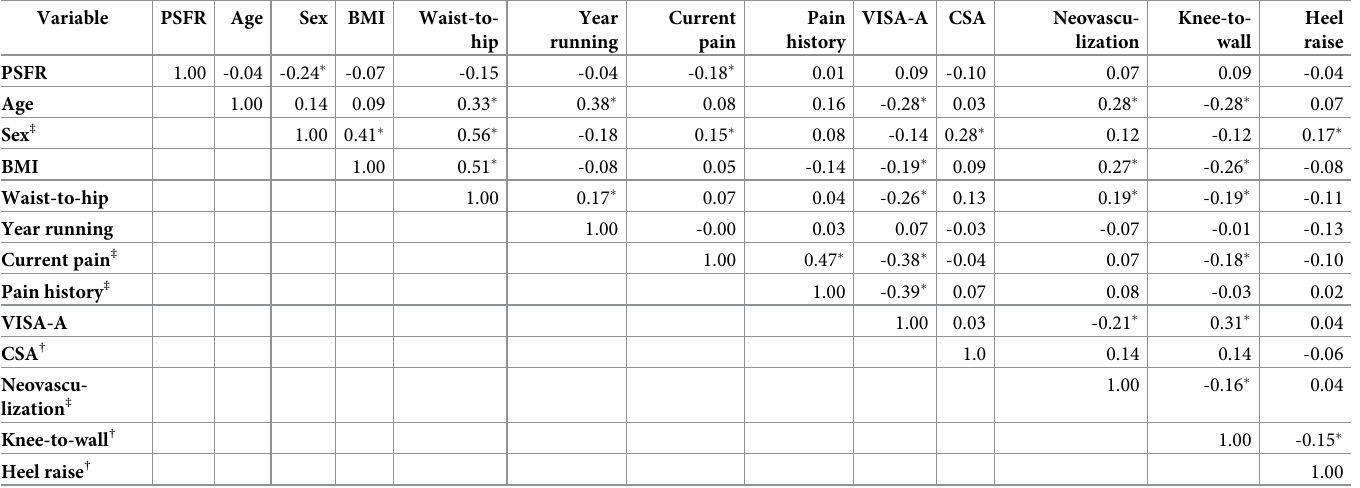
Table 2. Correlation coefficients of peak spatial frequency radius and related predictors.